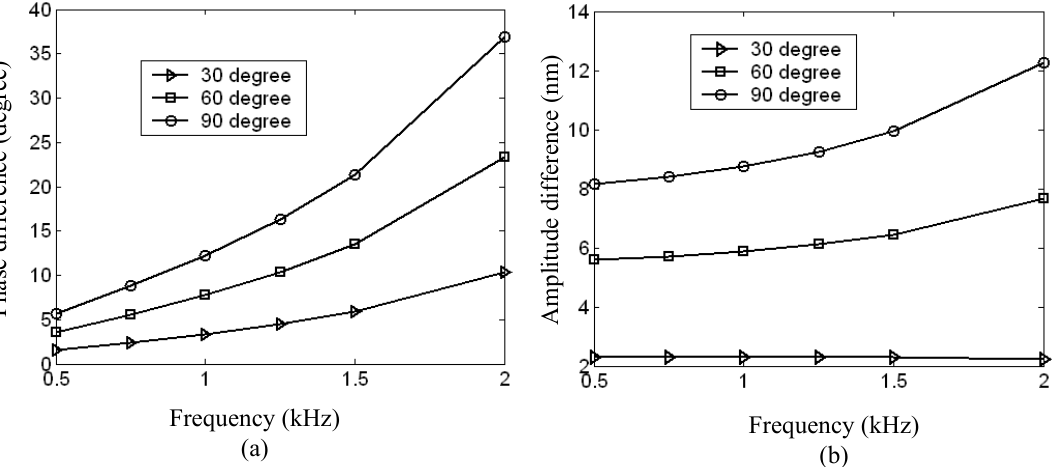
Figure 8. Phase difference (a) and amplitude difference (b) versus wave frequency and incident